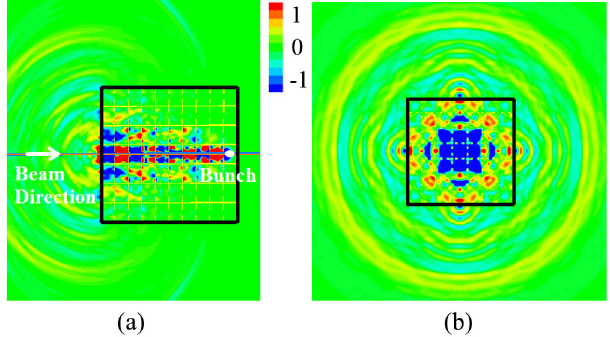
FIG. 7. The 3D properties. (a) Radiated E x field on an oblique cutting plane rotated 45° around the x axis starting from the y ¼ 0 plane. (b) Radiation pattern on the cutting plane of x ¼ const; i.e., the cutting plane is perpendicular to the longitudinal